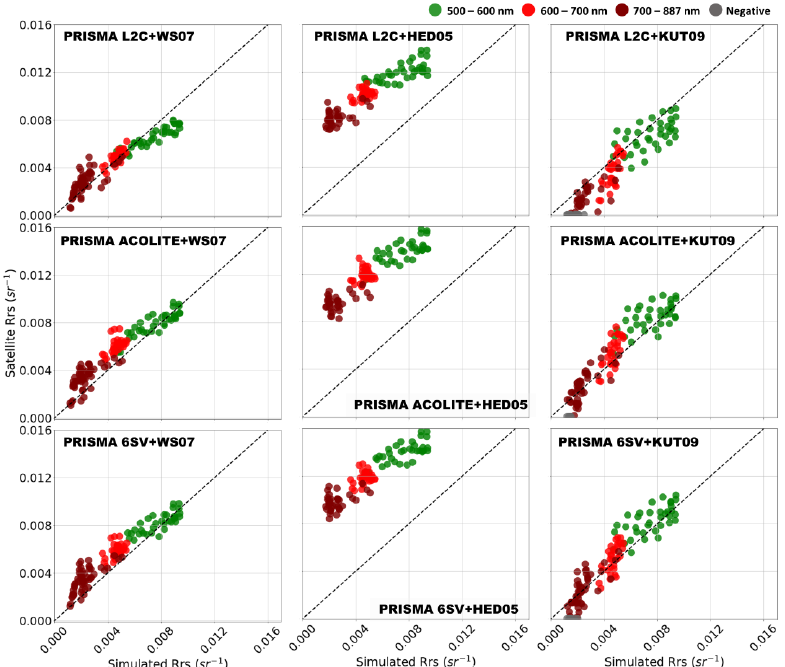
Figure 4. Scatterplots of in situ 𝑹 𝒓𝒔 resampled for PRISMA bands versus estimated PRISMA 𝑹 𝒓𝒔 for 3 October 2021, using three atmospheric correction algorithms (L2C, ACOLITE, and 6SV) and three glint methods (WS07, HED05, and KUT09) for the 500 – 885 nm spectral range. A 1:1 line is represented by the dashed line. Negative counts (gray) are plotted as zero.